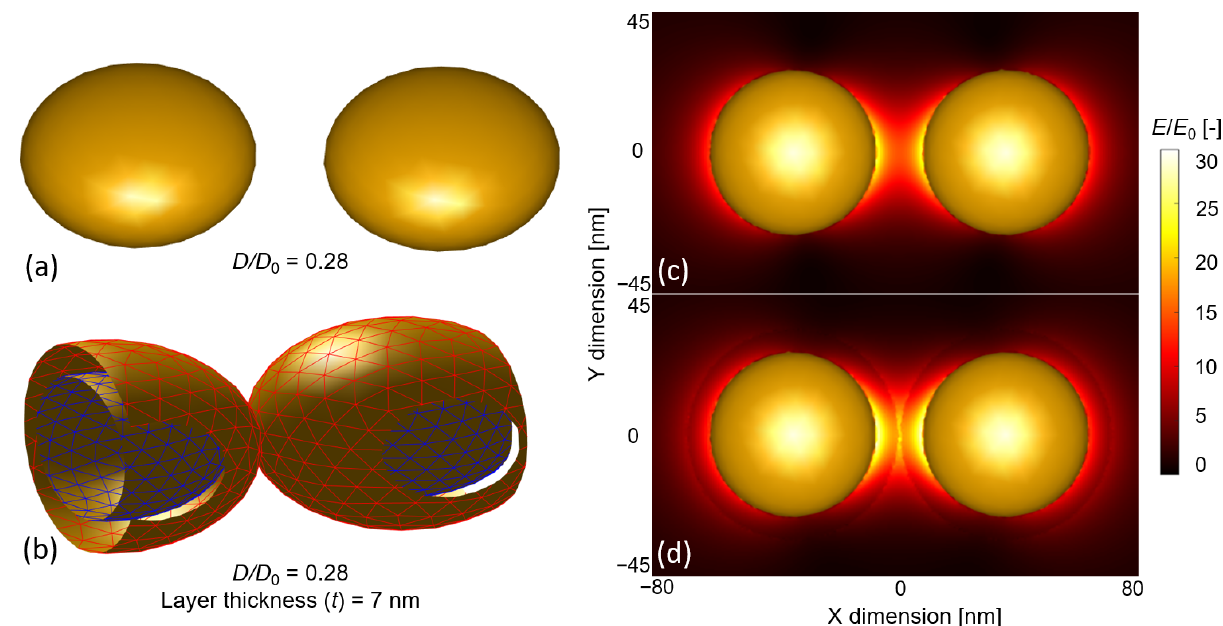
Figure 5. ( a ) An assembled nano-ellipsoid dimer in the MNPBEM toolbox, without layers in dielectric medium ( n = 1.33). ( b ) Sectional perspective of the same nano-ellipsoid dimer with a deposited dielectric layer ( n l = 1.5) of 7 nm. The blue mesh represents the vertices of the gold ellipsoids, while the red mesh represents the surface of the dielectric layer. ( c ) The distribution of the electric field around the gold nano-ellipsoid dimer is illustrated in ( a ). The map represents the Z = 0 plane (top view). ( d ) Electric field distribution for the dimer with dielectric layers illustrated in ( b ).